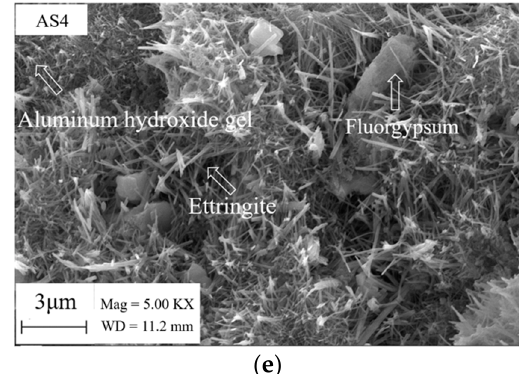
Figure 17. SEM images of double liquid grouting materials with di ff erent aluminum sulfate contents at 28 days: ( a ) 0%; ( b ) 1%; ( c ) 2%; ( d ) 3%; ( e ) 4%.